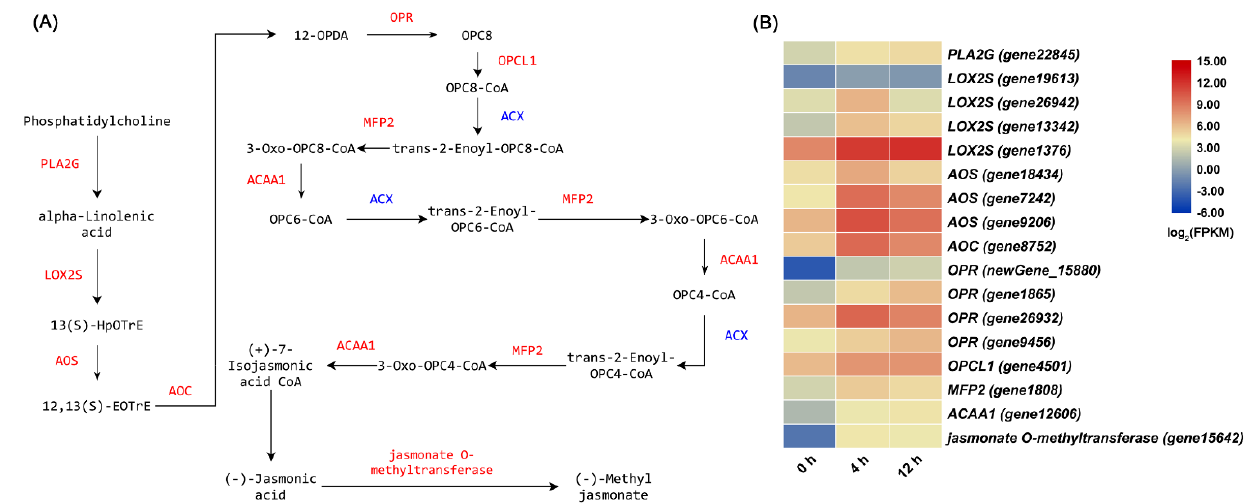
Figure 4. The jasmonic acid (JA) biosynthetic pathway and related upregulated genes under salt treatment. ( A ) The JA biosynthetic pathway and its associated enzymes. ( B ) Heat map analysis of upregulated gene expression in the JA biosynthetic pathway under salt treatment.